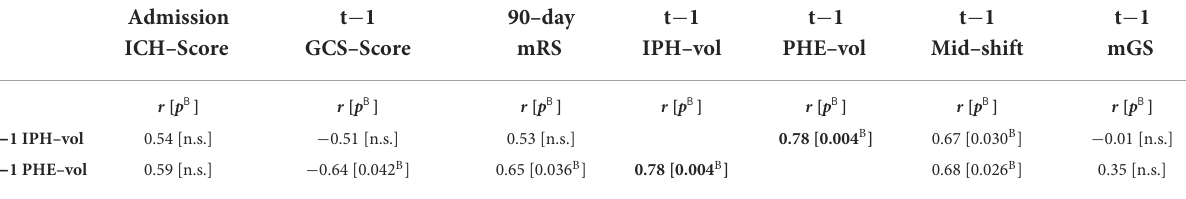
TABLE 2 Spearman rank correlation coefficients ( r) among clinical and radiological measures of sICH severity ( n = 13).